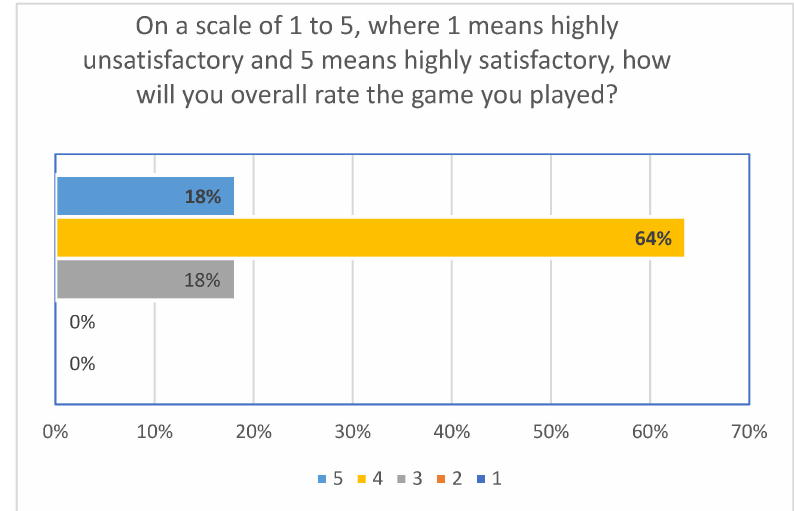
Figure 11. Respondents’ satisfaction with the overall game.